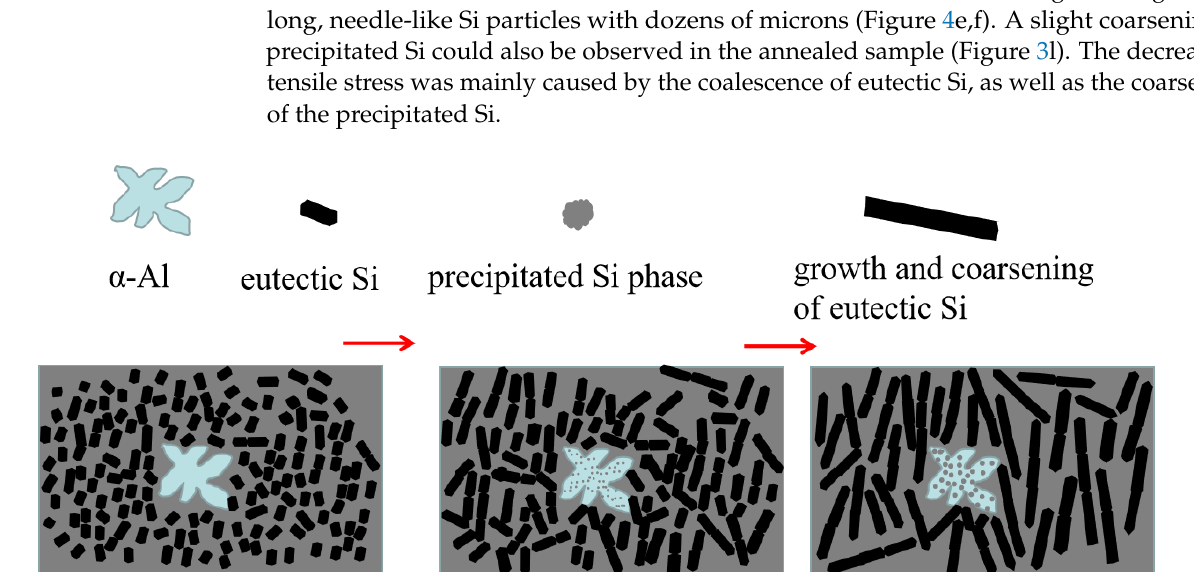
Figure 9. Schematic diagram of the coarsening of eutectic Si during the annealing process.